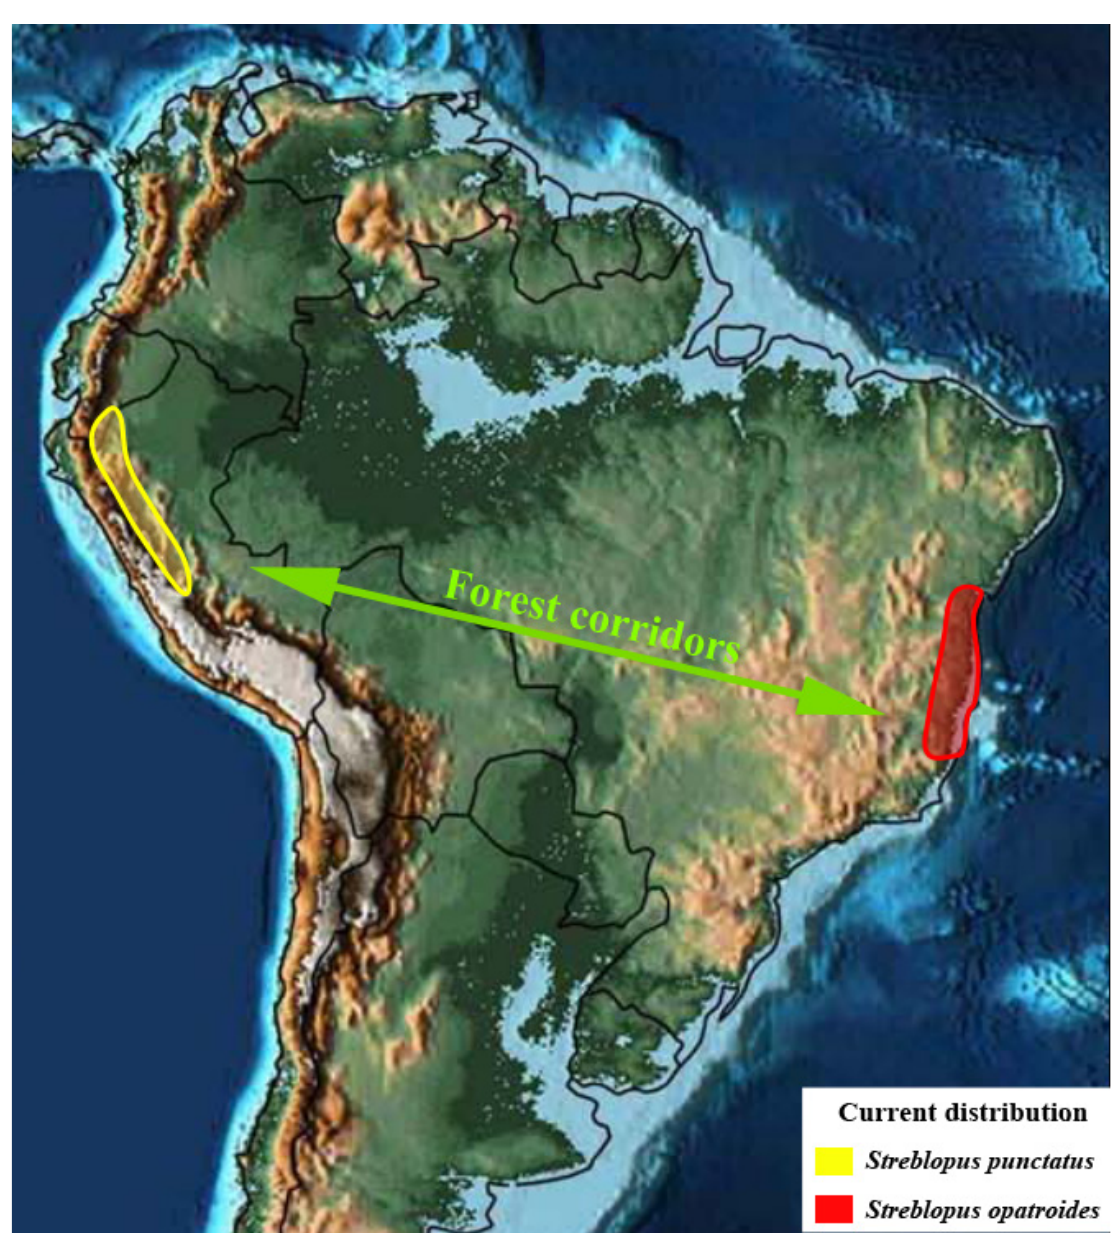
Fig. 28. Current distribution of Streblopus van Lansberge, 1874 plotted on a Middle Miocene palaeomap (~ 15 million years ago). Presently, both species of Streblopus are largely isolated from one another by means of the South America Dry Diagonal that separates the humid forests of the Amazon Basin from the Atlantic Forest on the South American eastern coast. This disjunct distribution is probably a result of the fragmentation of an once much more widely-distributed genus, which crossed the Dry Diagonal from the Atlantic Forest to southwestern Amazonia through forest corridors connecting those two biomes during periods of warmer climate over the past 25 million years. When the climate cooled and the tropical forests retreated, the open and drier environments of the Dry Diagonal advanced, and the populations of Streblopus in the Atlantic Forest and in the Amazon became isolated. It is known that the Middle Miocene experienced the highest temperatures of the last 20 million years (Zachos et al. 2001), and perhaps it was during its ʻclimate optimumʼ about 15 million years ago that the Amazonian and the Atlantic Forest populations of Streblopus were connected for the last time. Palaeomap modified from Scotese